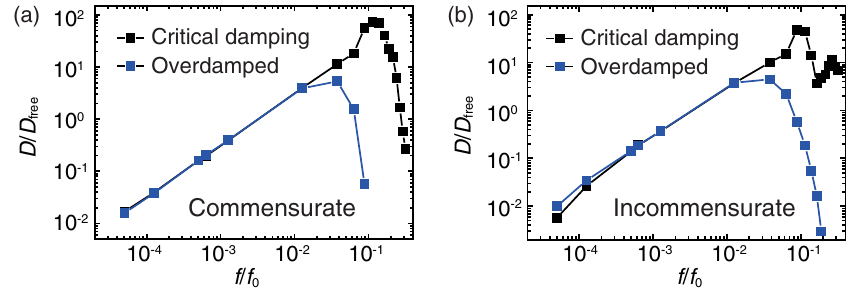
FIG. 4. Diffusion coefficients with different damping coefficients for adsorbates confined between the (a) commensurate and (b) =a ¼ 0 . 95 ) surfaces. The oscillation amplitude is A ¼ 2 a incommensurate ( a sub sld are two times larger than their values for the critical